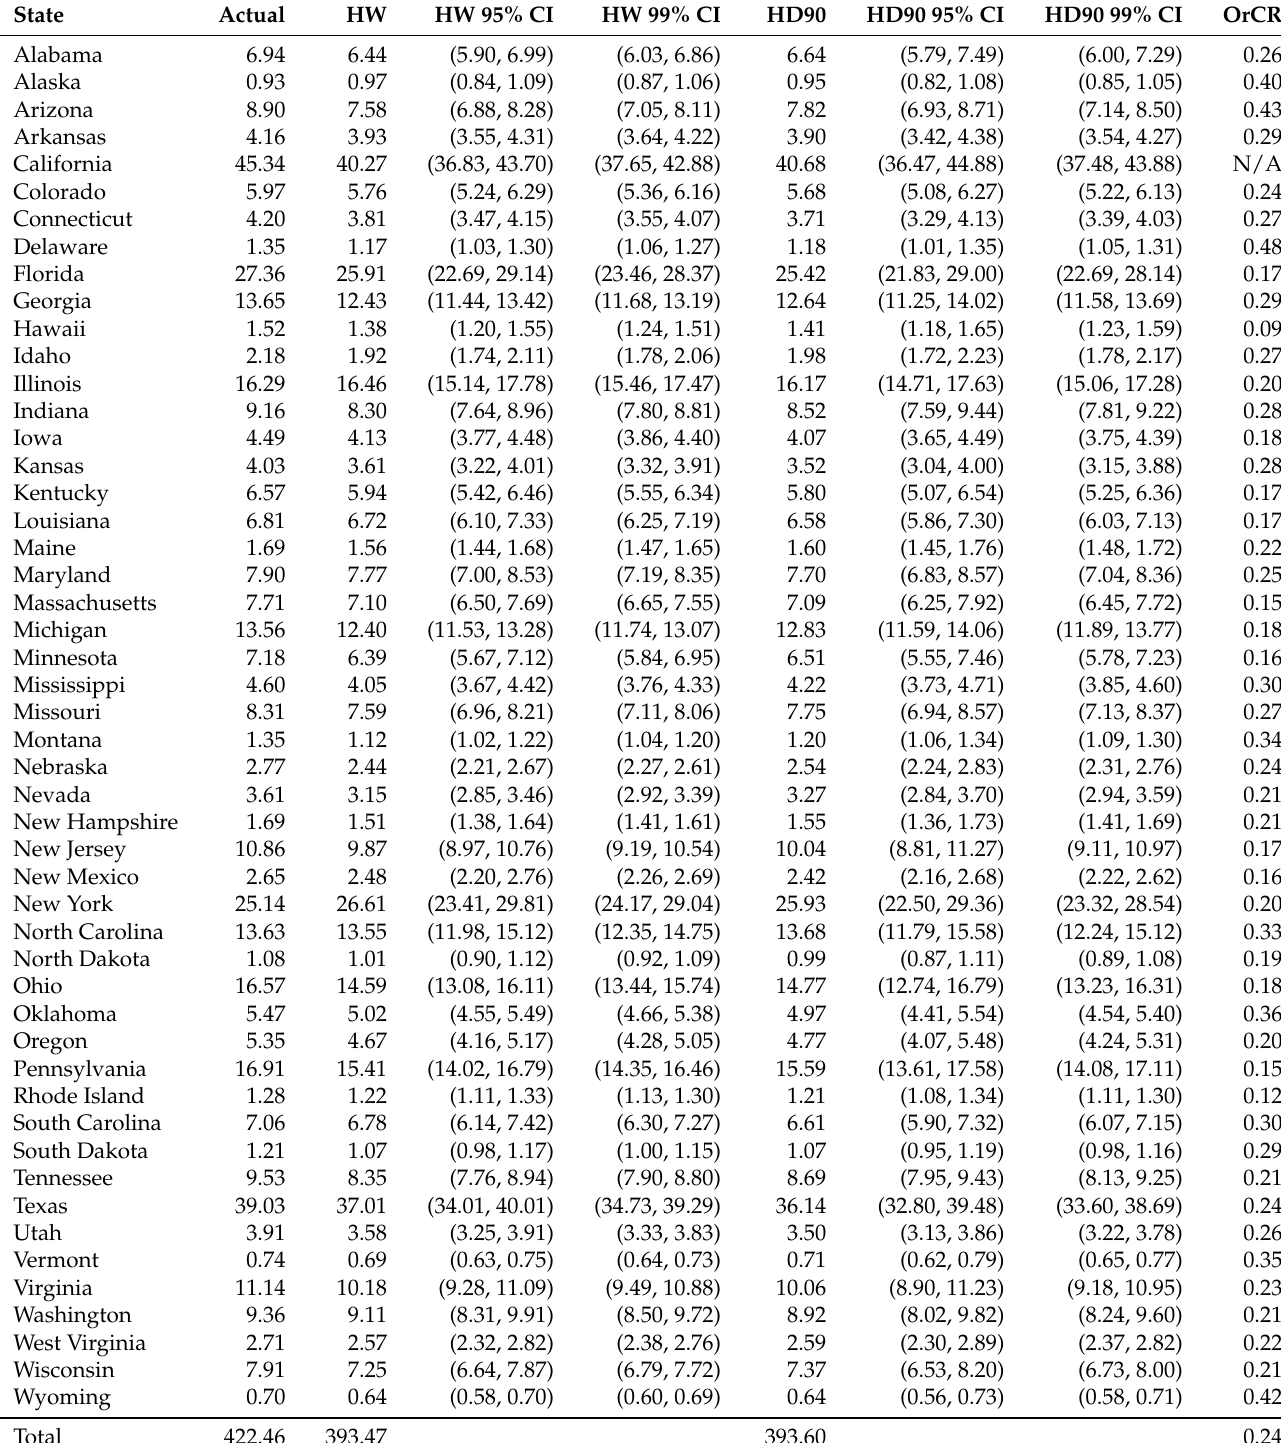
Table 5. Summary of the Holt’s (HW) and the damped Holt’s (HD) forecast by state for 2018. The 95% and 99% prediction intervals are provided with each forecasting method. Column labeled “Actual” values shows the 2018-cost calculated based on the method developed in Section 2. All costs are expressed in the values of 2018 billions of